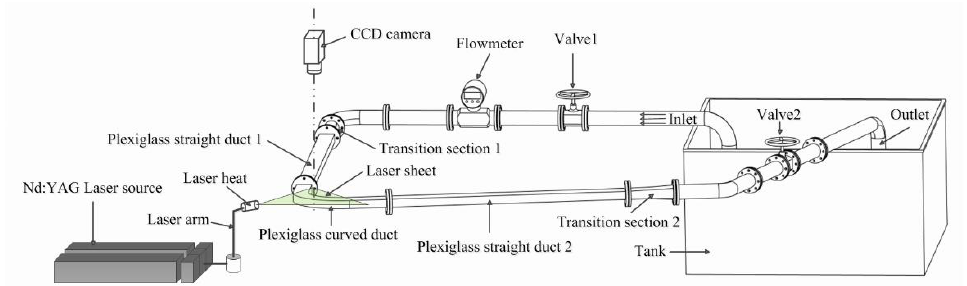
Figure 3. Schematic of the closed-loop duct/pipe facility with PIV system[29].